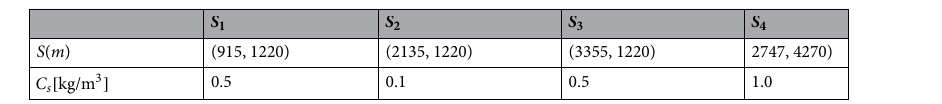
Table 5. Exact point-sources’ position and concentration in the case of 4 sources.